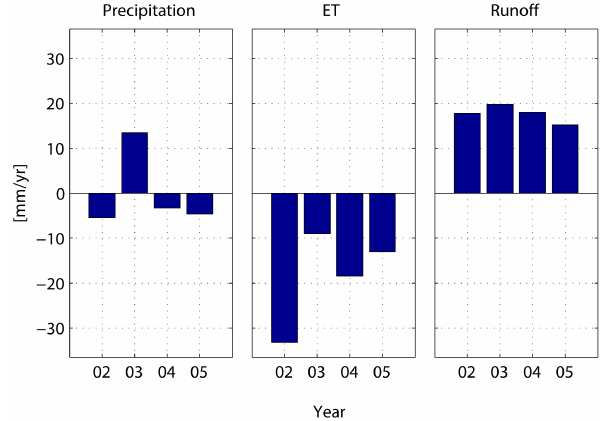
Figure 4. Difference in mean continental precipitation, evaporation and total runoff, between the actual vegetation case and potential vegetation case